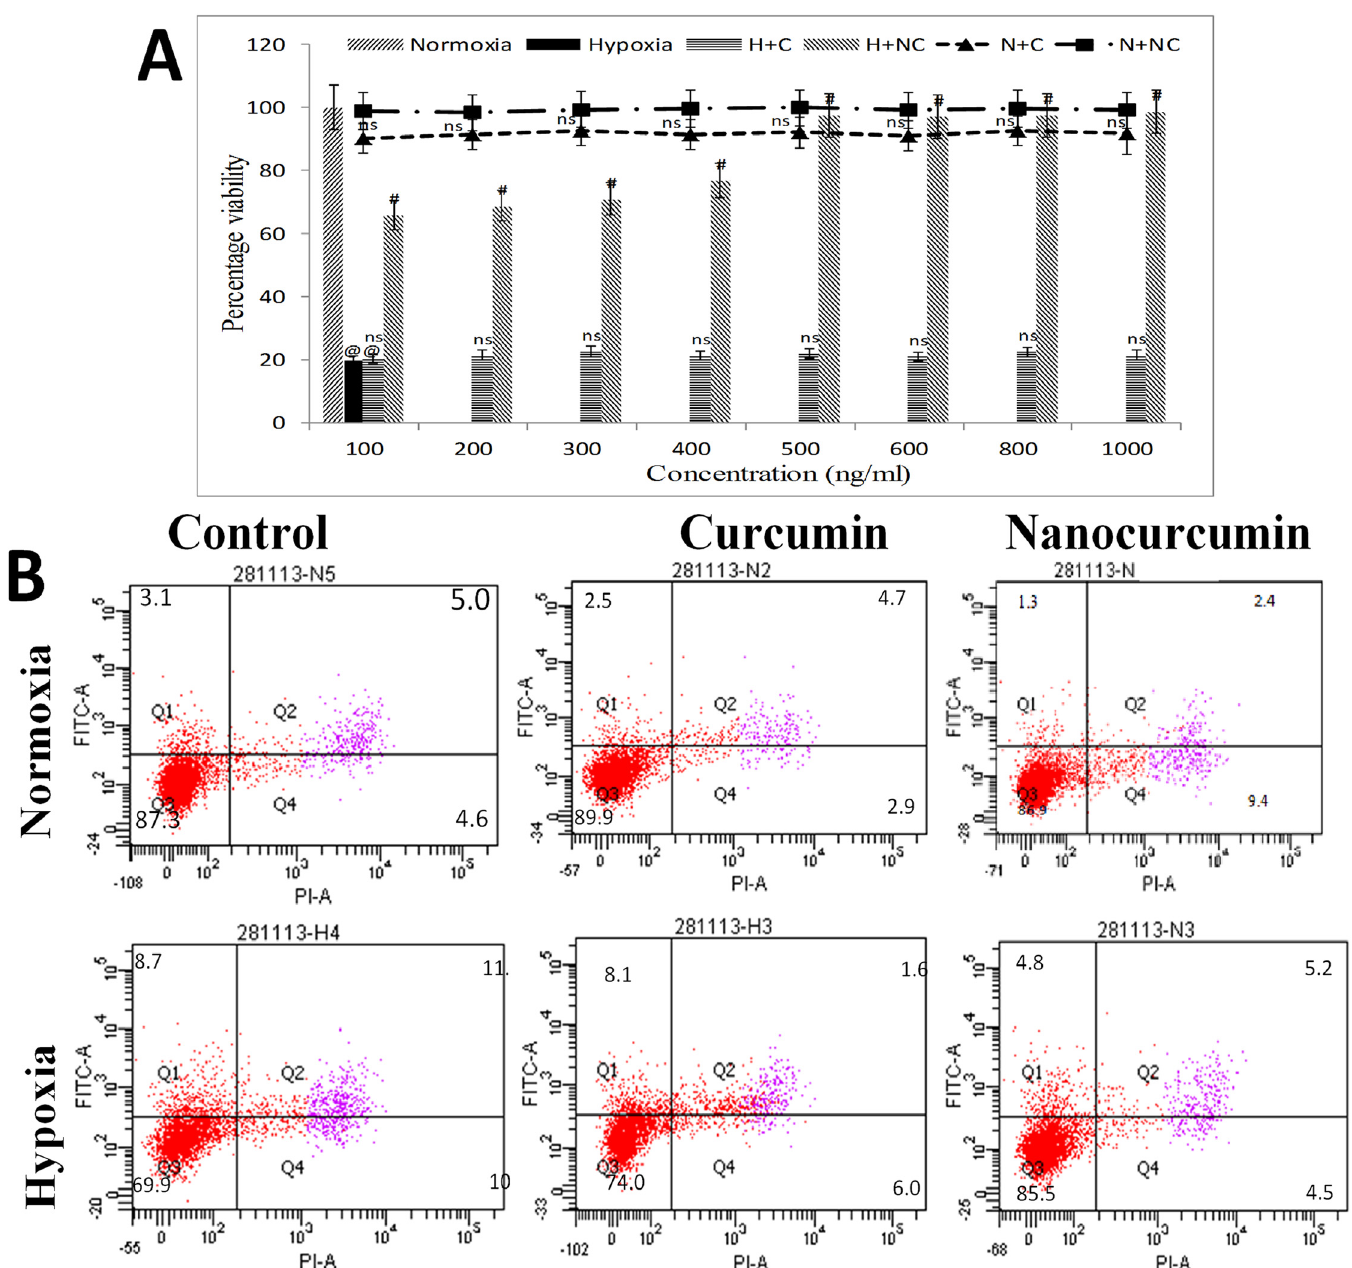
Fig 1. Nanocurcumin improves cellular viability under hypoxia: (A) Hypoxia insult caused decline in cell viability (20%) compared to normoxia control cells by 24 h. (B) Nanocurcumin treatment at 500 ng/ml significantly improved cellular viability (89%) by 24 h of hypoxia exposure and confirmed by FACS. Curcumin treatment did not show significant improvement in cellular viability at any time point. No significant change in cell viability was observed in nanocurcumin or curcumin treated cells under normoxia. Nanocurcumin treatment at 500 ng/ml was used for further experiments. Values are mean ± SD, significant values represented as @@ p (cid:1) 0.01 vs normoxia and # p (cid:1) 0.01 vs hypoxia. Non-significant changes are designated as